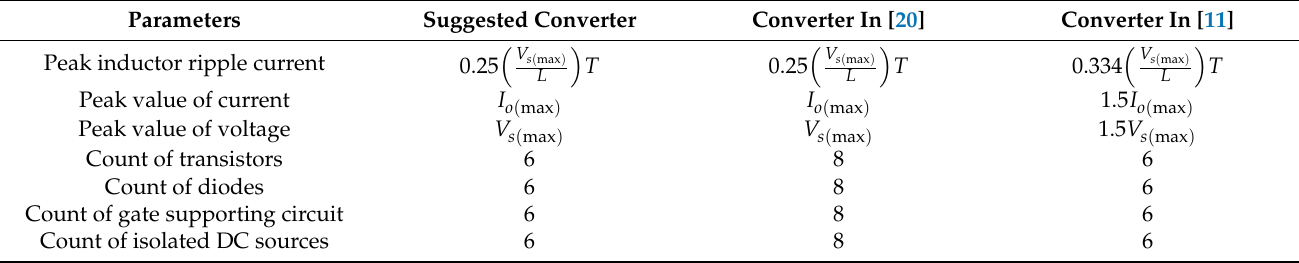
Table 1. Comparison of the performance evaluation for inverting voltage step-down output considering a factor of 0.5.